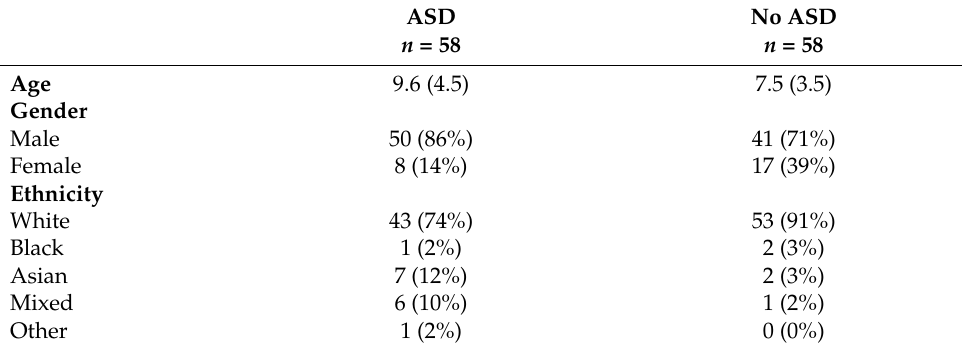
Table 2. Demographic characteristics by clinical interview diagnosis.